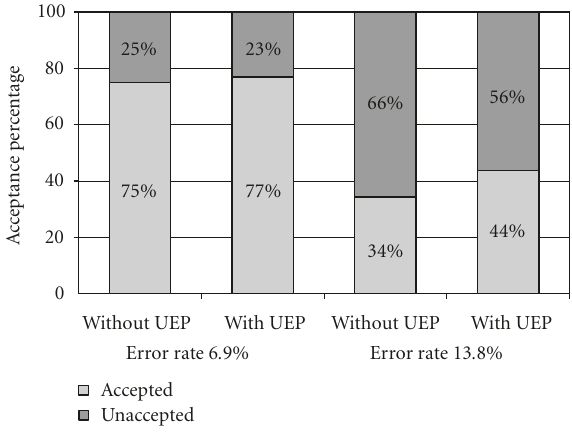
Figure 8: Overall acceptability rating of UEP